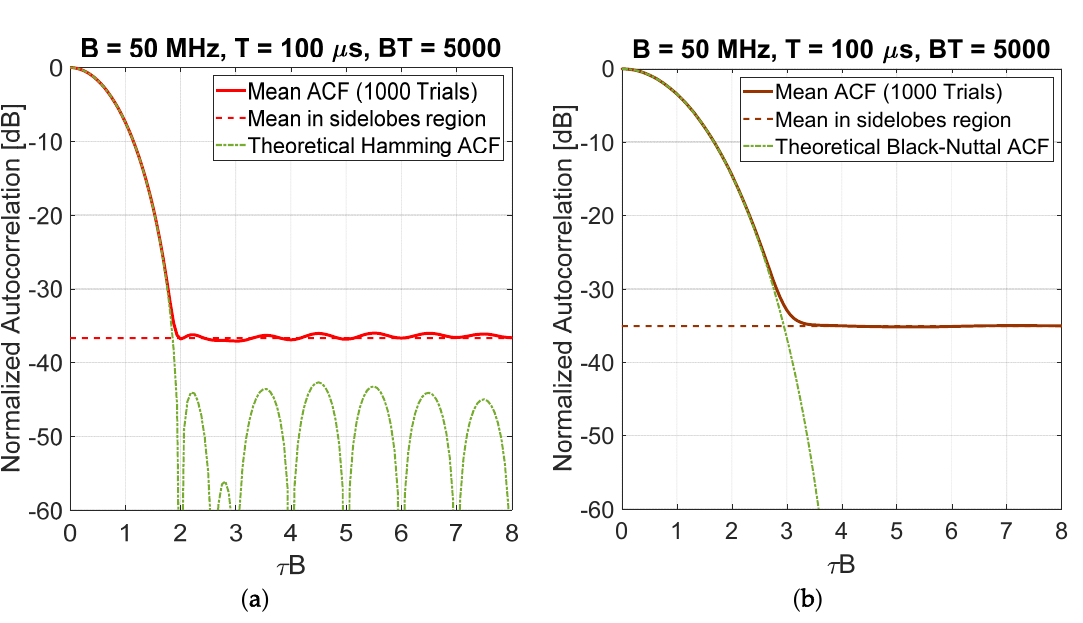
= 36.69 Figure 11. Normalized autocorrelation function (ACF): (a) Hamming noise waveform (cid:2015) (cid:3548) Figure 11. Normalized autocorrelation function (ACF): ( a ) Hamming noise waveform ˆ η r = 36.69 dB; (cid:1870) = 35.08 dB . Case (a) grants a better range resolution. dB; (b) Blackman-Nuttall noise waveform (cid:2015) (cid:3548) ( b ) Blackman-Nuttall noise waveform ˆ η r = 35.08 dB. Case ( a ) grants a better range (cid:1870)